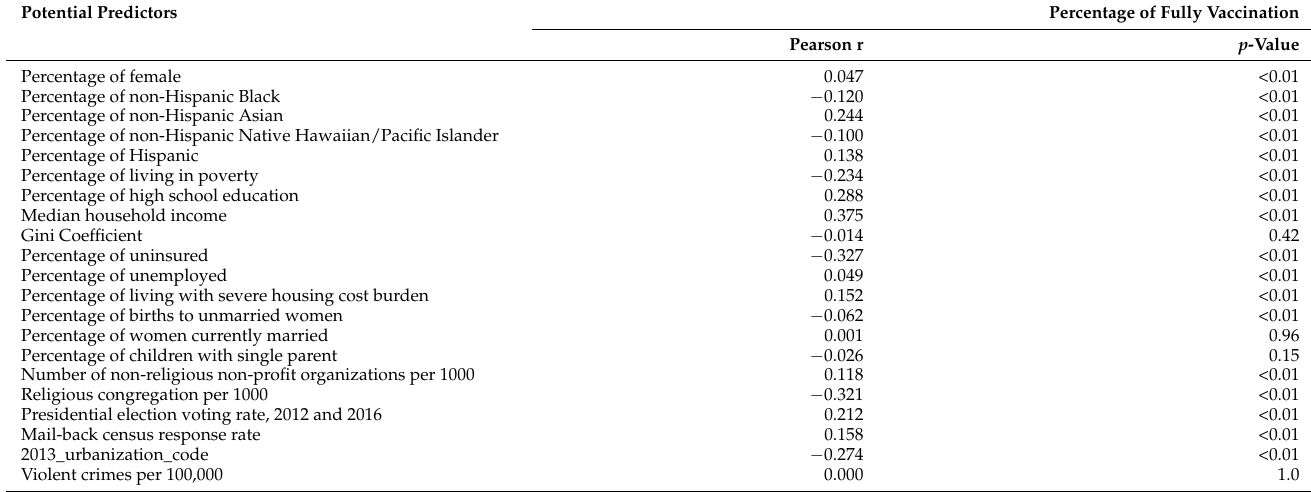
Table A2. Results of bivariate